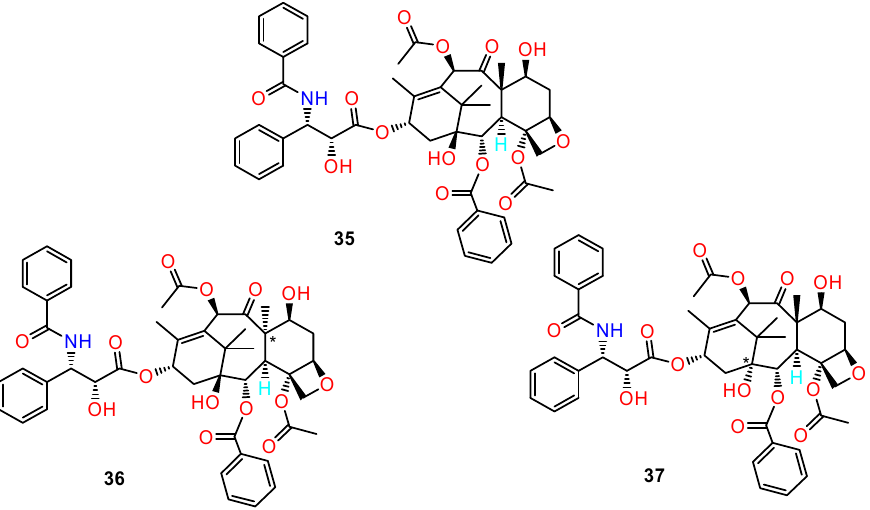
Figure 16. The structure of Taxol ( 35 ) and its diastereoisomers ( 36 – 37 ) with high affinity to β -tubulin according to molecular modelling studies. * stereogenic centre.